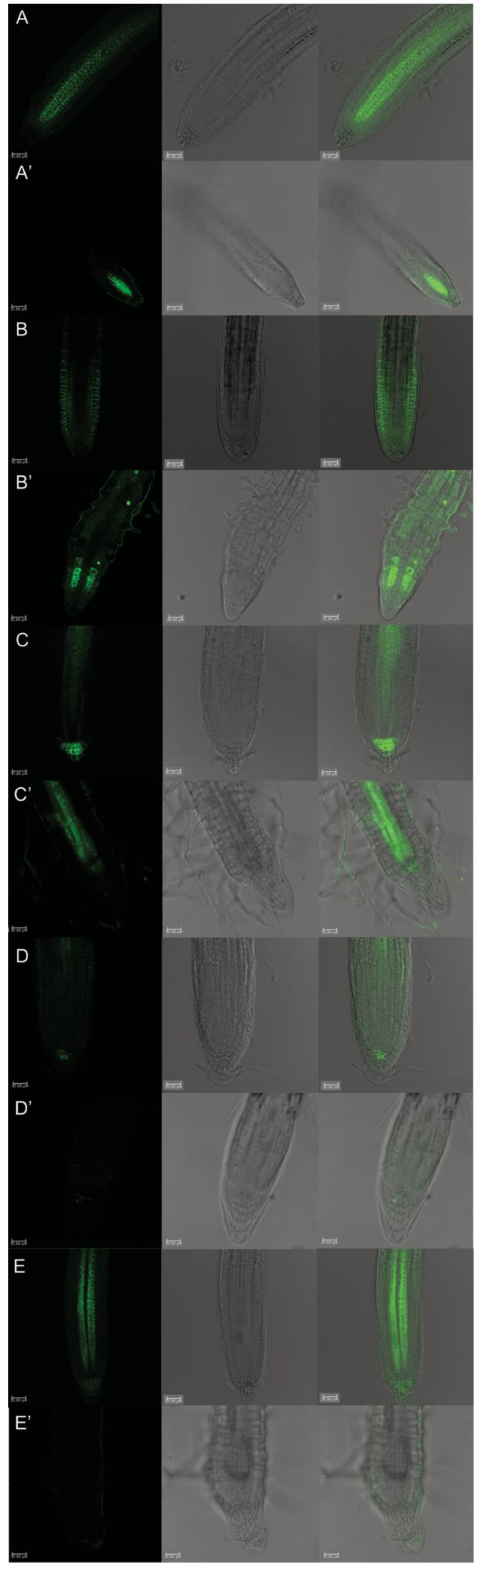
Figure 7. Primary root apex in seedlings of Arabidopsis pPIN1::PIN1-GFP , pPIN2::PIN2-GFP , pPIN3::PIN3-GFP , pPIN4::PIN4-GFP , pPIN7::PIN7-GFP transgenic lines untreated ( A – E ) and treated with 50 µ M protodioscin for 6 d ( A (cid:48) – E (cid:48) ). Scale bars 32.88 µ m. Left side, GFP signal; center, transmis- sion image; right side, merged image. N =